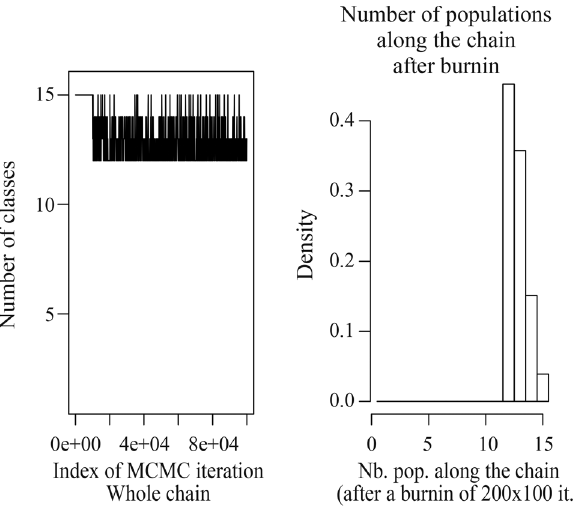
Figure 1 - Plot of the number of populations simulated from the posterior distribution obtained with